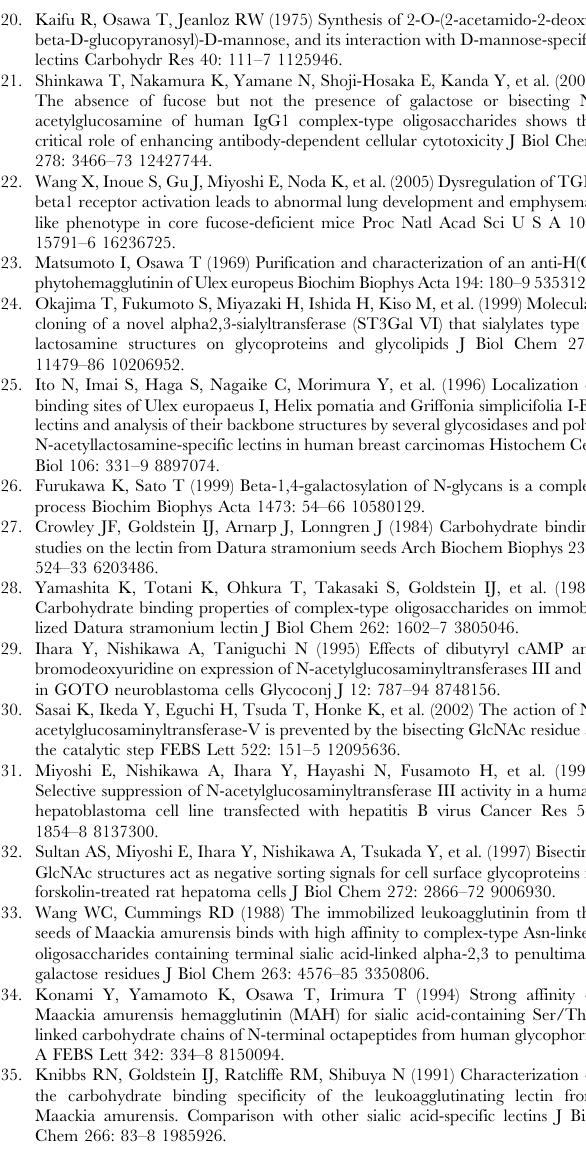
Table S2 Lists of correlated genes with lectin staining: This is an Exel file consists of 14 worksheets. First sheet shows full list of genes spotted on the Glycan-focuesed microarray and their gene ID numbers. Following sheets are the lists of genes that